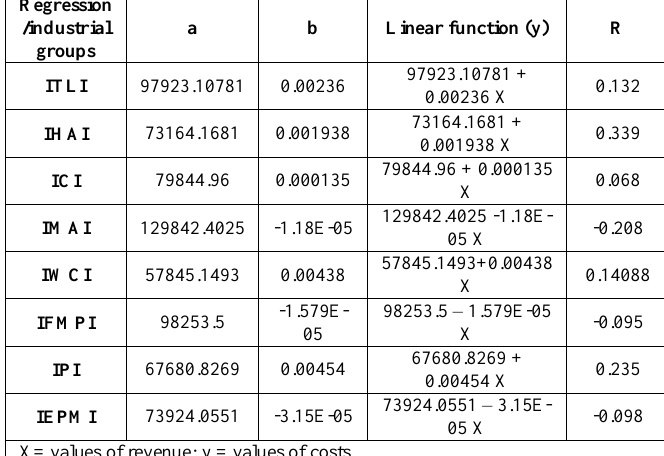
Table 3: The results of regression analysis.